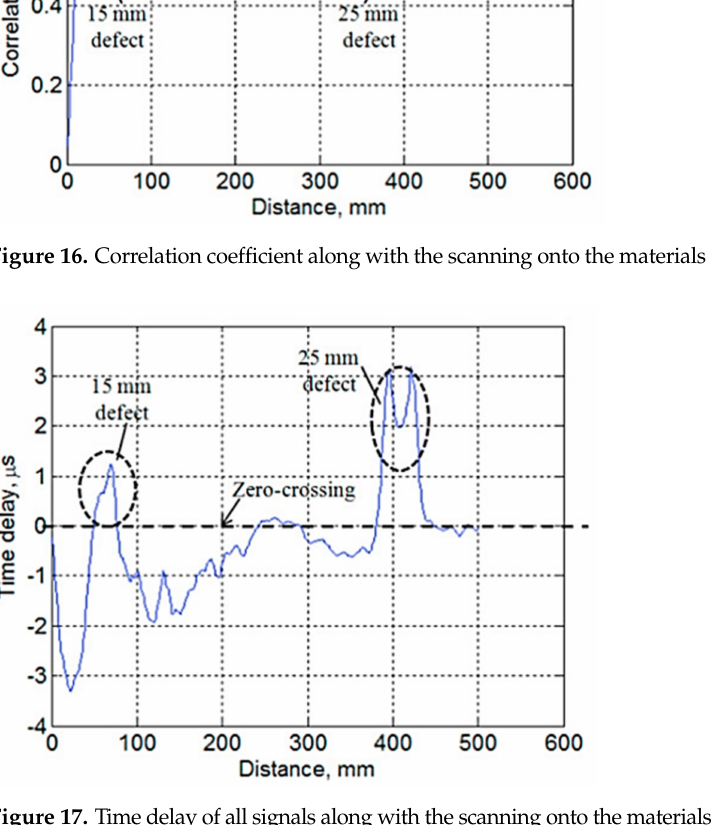
Figure 17. Time delay of all signals along with the scanning onto the materials using cross-correlation